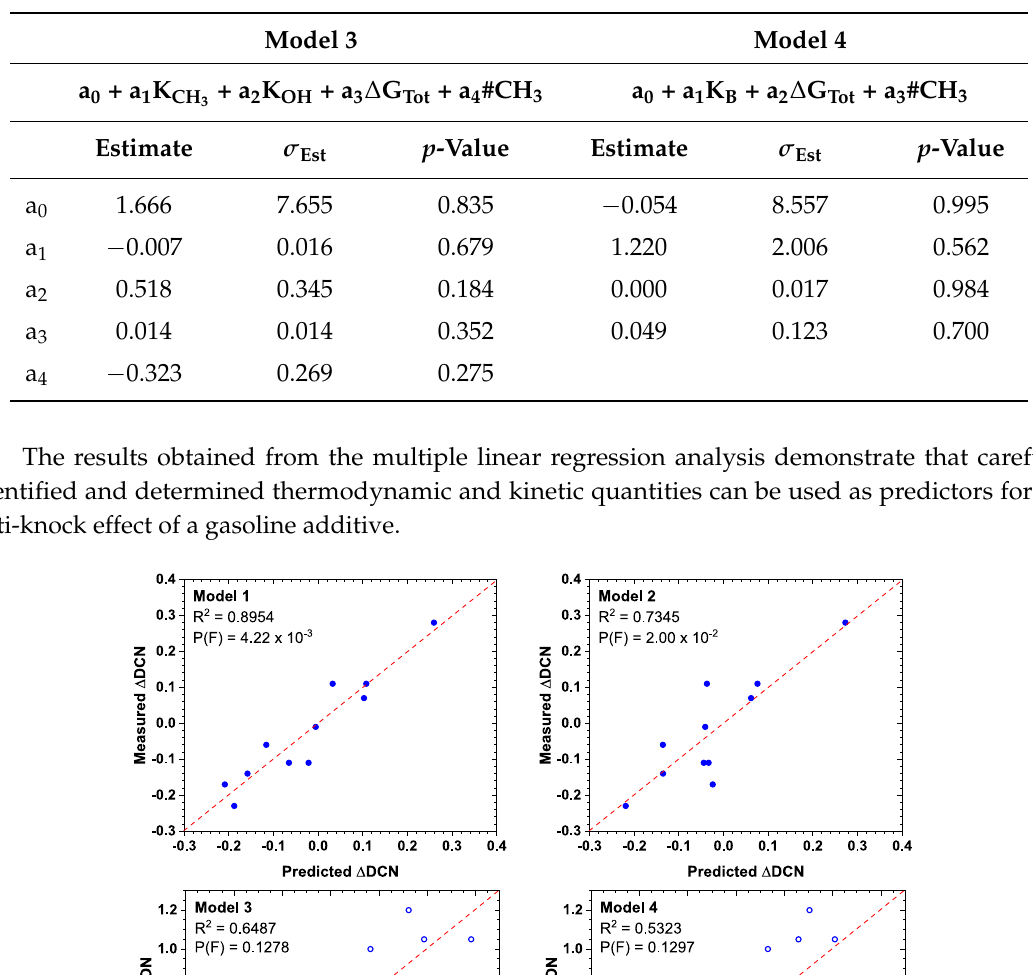
Table 3. Summary of Models 3 and 4, trained to ∆ RON.